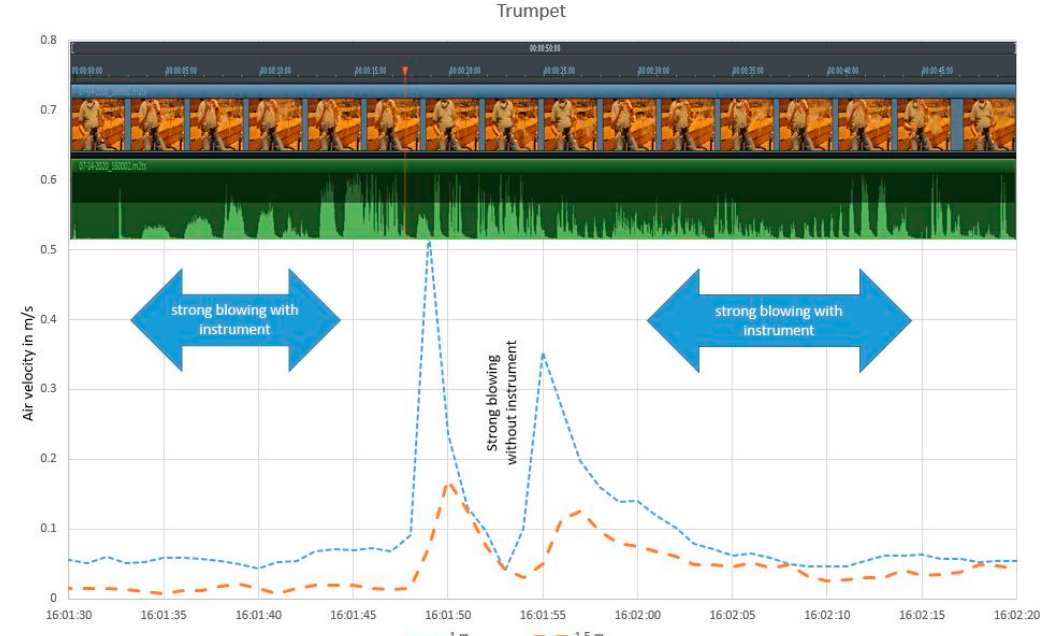
Figure A6. Example measurements (trumpet): blowing, with and without the instrument. Note: This is an example of the measurements (trumpet). Screenshots from the qualitative videos can be seen at the top, followed by the waveform of the audio recording in green. It shows the different measurements of airflows between warming up (when the player blows into the instrument’s mouthpiece) and blowing long tones with the instrument. At 2 m no more airflows were measurable; therefore, the 2 m line is irrelevant and not included in the graphic.